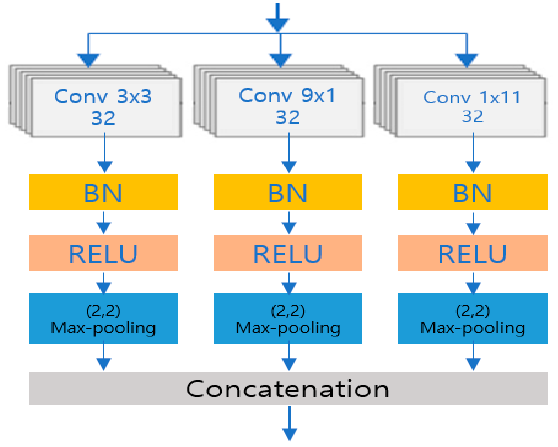
Figure 3. Parallel CNNs encoder of MFCC.